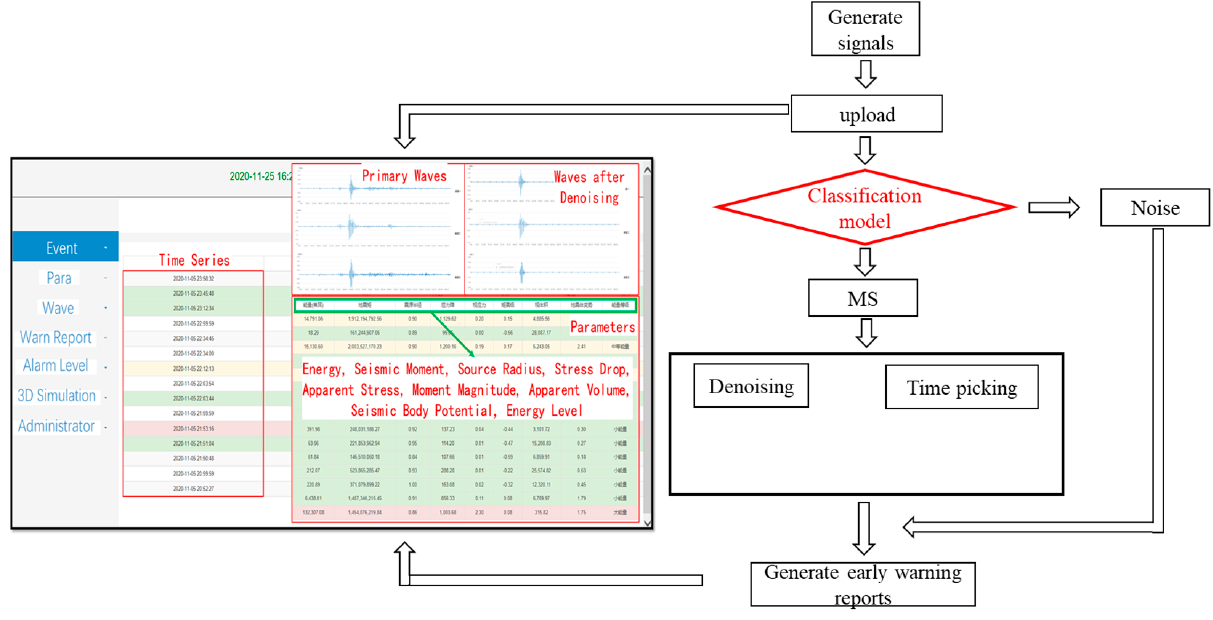
Figure 9. Program structure of the early warning system.